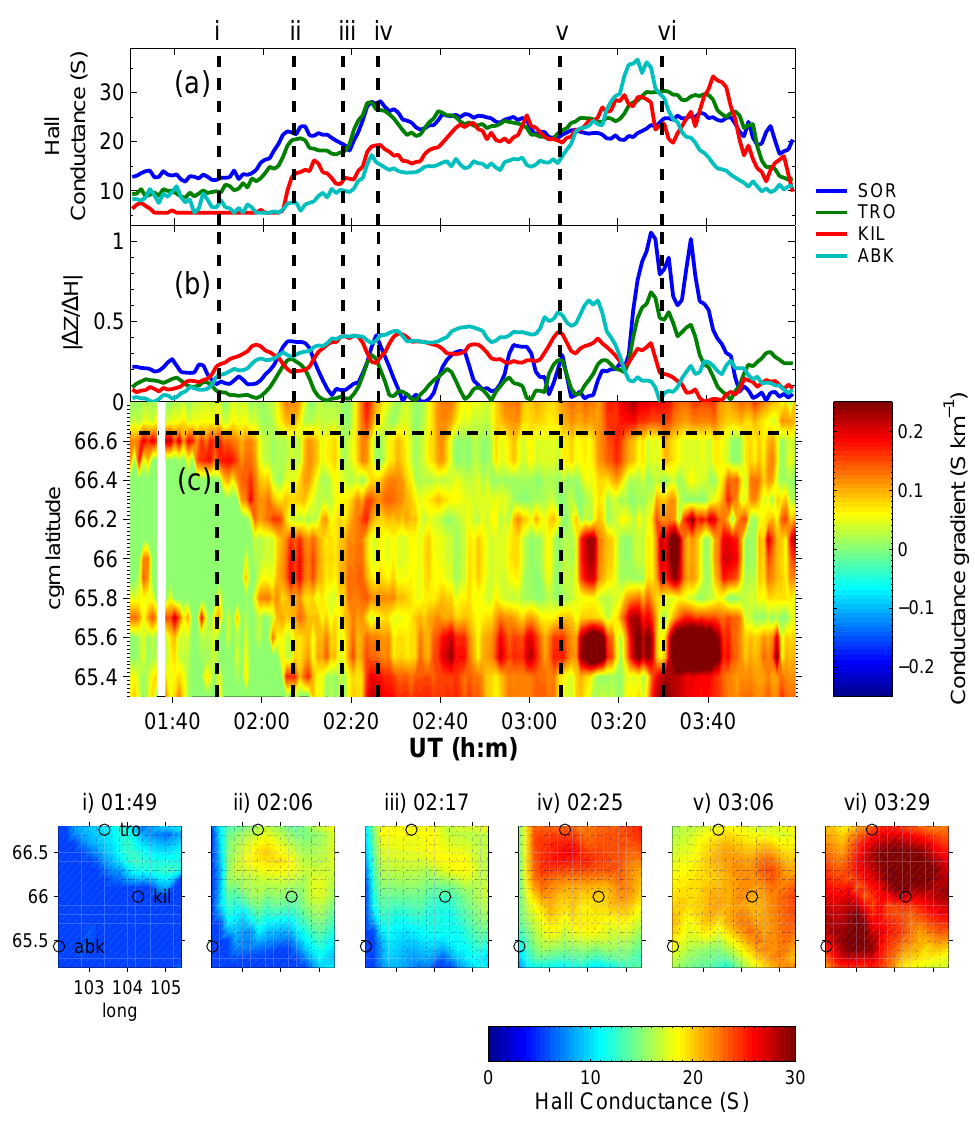
Fig. 8. (a) Estimates of Hall conductance from IRIS for beams closest to the indicated magnetometers. (b) The magnitude of dX/dZ (ratio of the vertical and horizontal perturbations) derived for the four magnetometers. (c) Keogram (at the cgm longitude of TRO) showing the longitudinal gradient in the conductance. The horizontal dash-dot line indicates the latitude of TRO. The bottom panels show instantaneous conductance maps derived from IRIS measurements for 6 selected intervals including: i) efore the Ps6; ii)–iv) peak-trough-peak through a cycle, v) the end of the pulsation; vi) during the subsequent precipitation